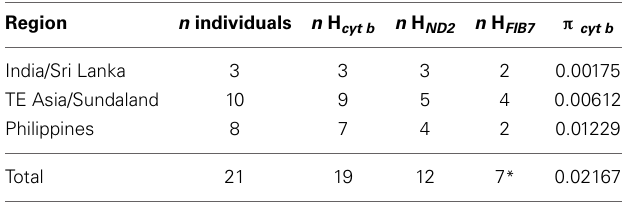
Table 2 | Summary of sequence results for the coppersmith barbet